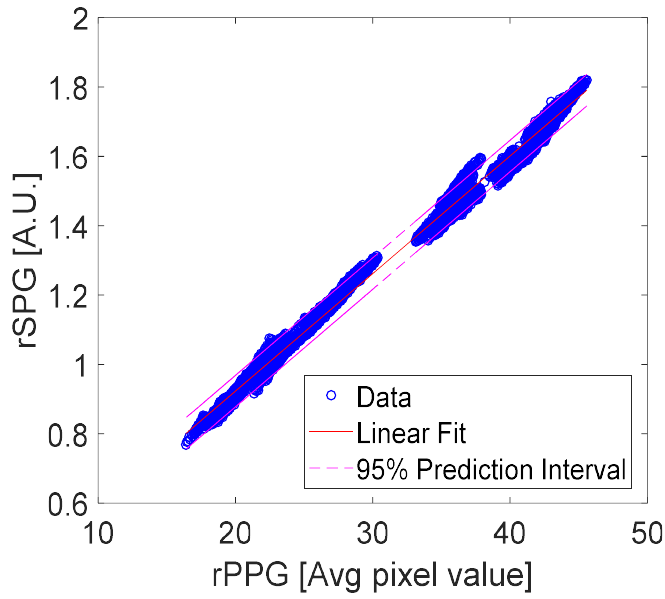
Figure 17. Linear regression of rPPG and rSPG data with a 95% prediction interval. Table 4. Linear regression statistics of rPPG vs. rSPG data with a 95% prediction interval. Regression Statistics rPPG versus rSPG R-Squared 0.997 Standard Error